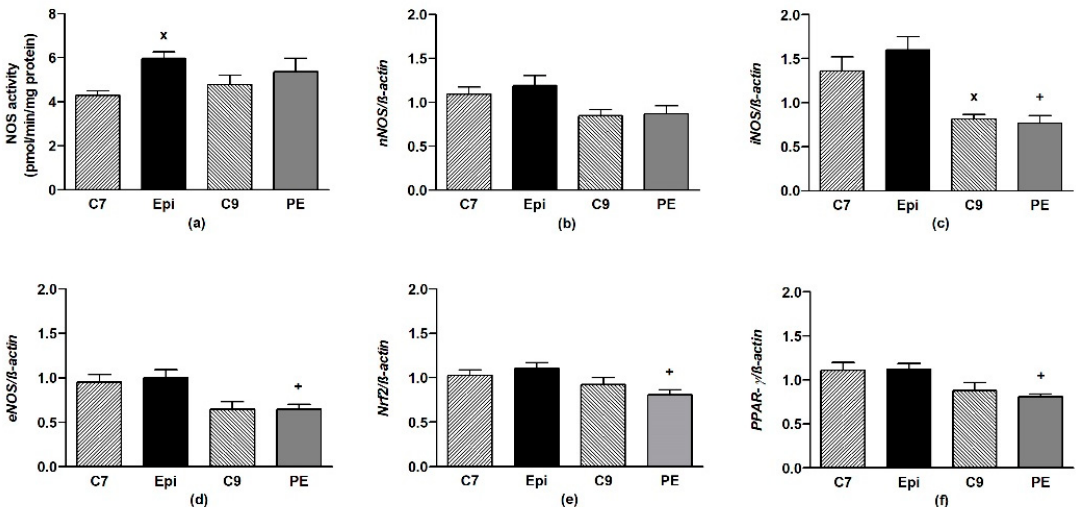
Figure 5. The e ff ect of (–)-epicatechin on the nitric oxide synthase (NOS) activity ( a ) and gene expression of neuronal nNOS ( b ), inducible iNOS ( c ), endothelial eNOS ( d ), Nrf2 ( e ) and PPAR- γ ( f ) in the aorta of borderline hypertensive rats. The values represent the mean ± SEM; n = 6–7 per group. x p < 0.05 vs. C7 group, + p < 0.05 vs. Epi group. Abbreviations: C7: seven-week-old control group, C9: nine-week-old control group, Epi: (–)-epicatechin group, PE: (–)-epicatechin post-treatment group, Nrf2: nuclear factor erythroid 2-related factor 2, PPAR- γ : peroxisome proliferator-activated receptor gamma.